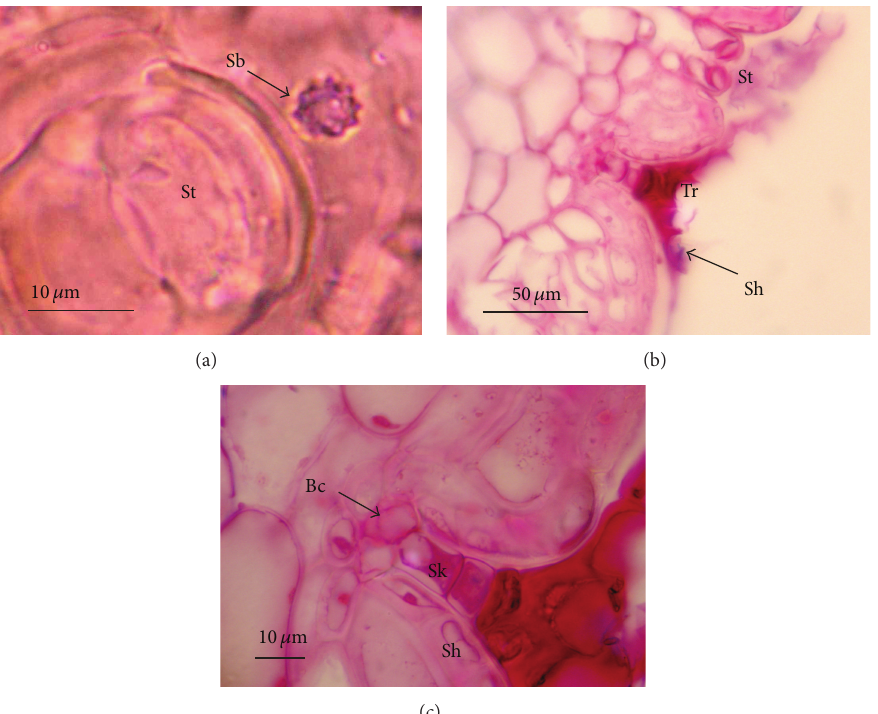
Figure 3: Leaf blade of Dyckia brevifolia Baker, as observed in light microscopy. (a) Frontal view of the abaxial surface, showing siliceous body (Sb) with rough surface. ((b) and (c)) Cross section showing abaxial surface. (b) General view showing trichome (Tr) in epidermis depression and stomata (St). (c) Detail showing the trichome formed by basal cells (Bc), stalk (Sk), and shield